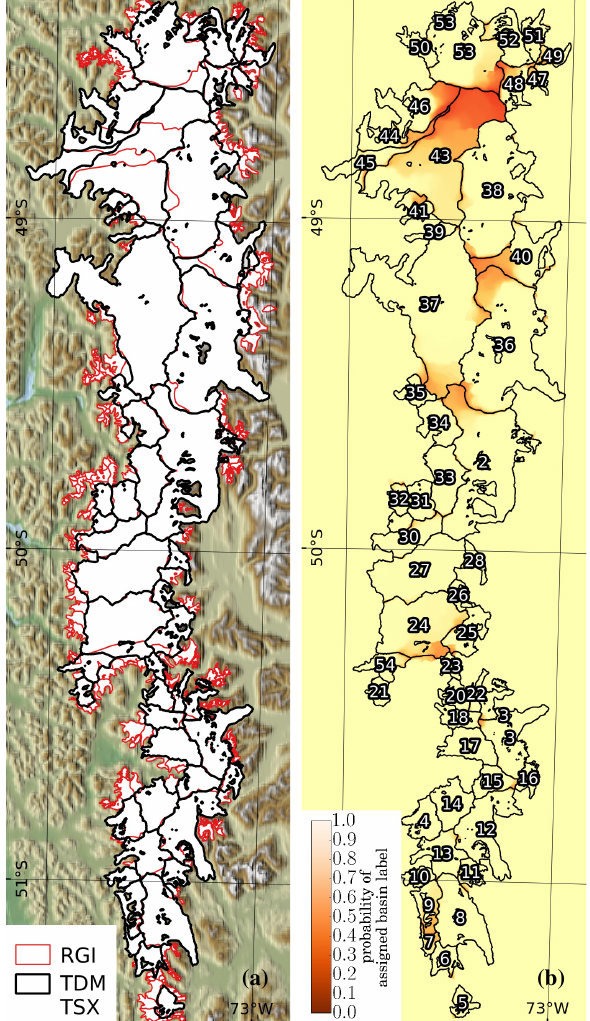
Figure 2. The SPI and its (a) catchment delineations in the RGI (red) with our delineations from the TDM global DEM and TSX velocities (black). (b) the corresponding basin probabilities for the TDM/TSX drainage basin